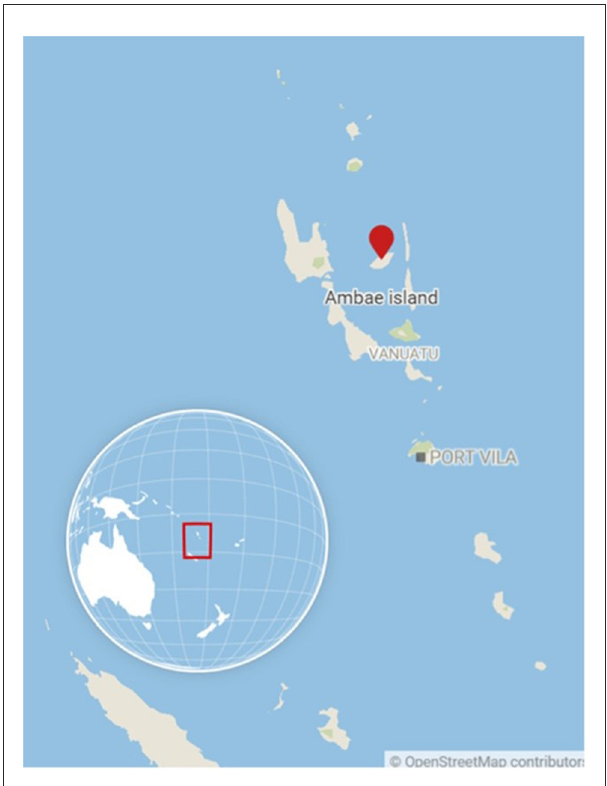
FIGURE2 Map of Vanuatu with Ambae island indicated. Image Source: OpenStreetMap.